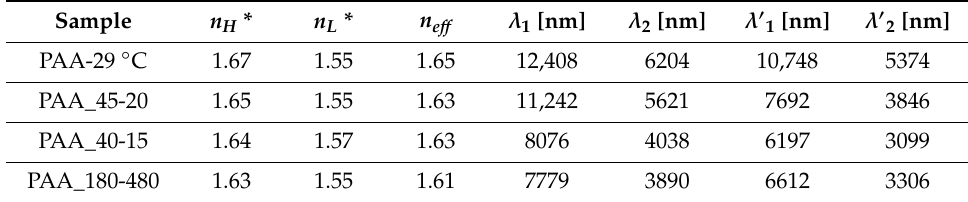
Table 3. Optical indices ( n H and n L are refractive indices of the respective d Hinit and d Linit segments, n e ff is the e ff ective refractive index) and PSBs calculated for d Hinit and d Linit ( λ 1 and λ 2 ) and for d H and d L ( λ (cid:48) 1 and λ (cid:48) 2